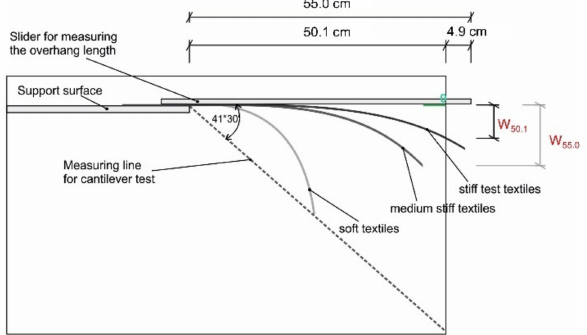
Figure 4. Schematic illustration of the determination of the bending stiffness of stiff, medium stiff and soft